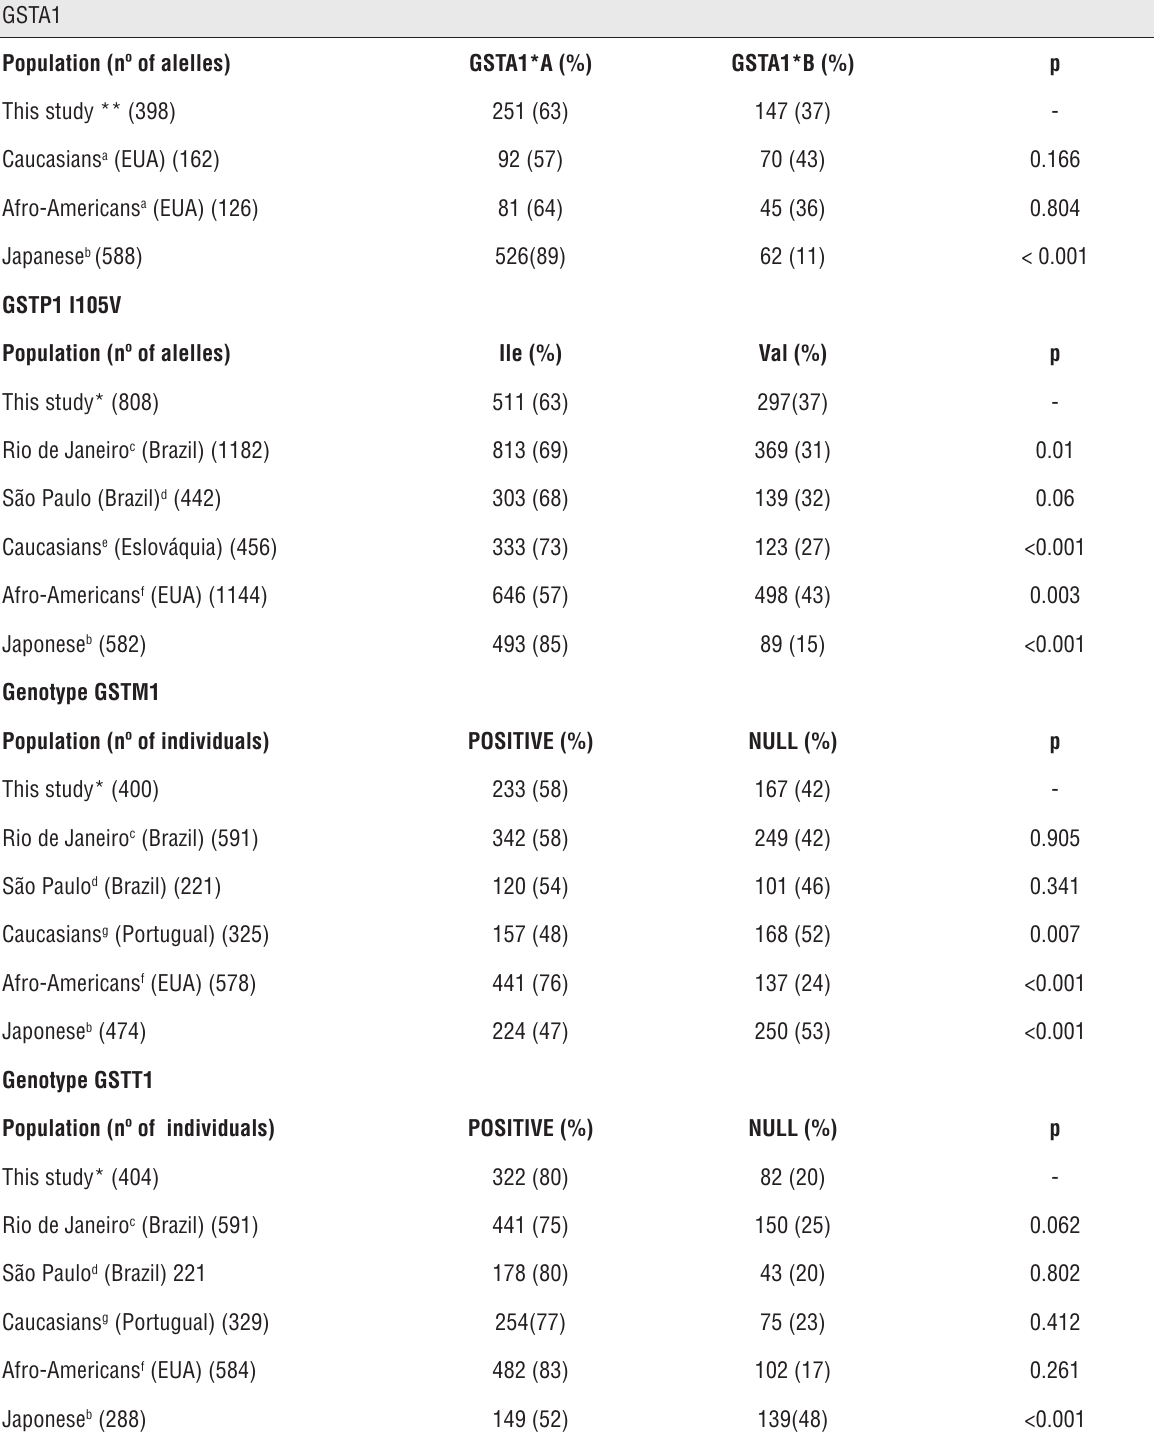
Table 4 - Comparison of allelic polymorphisms of GSTA1, GSTM1, GSTT1 and GSTP1 I105V in the study population and different